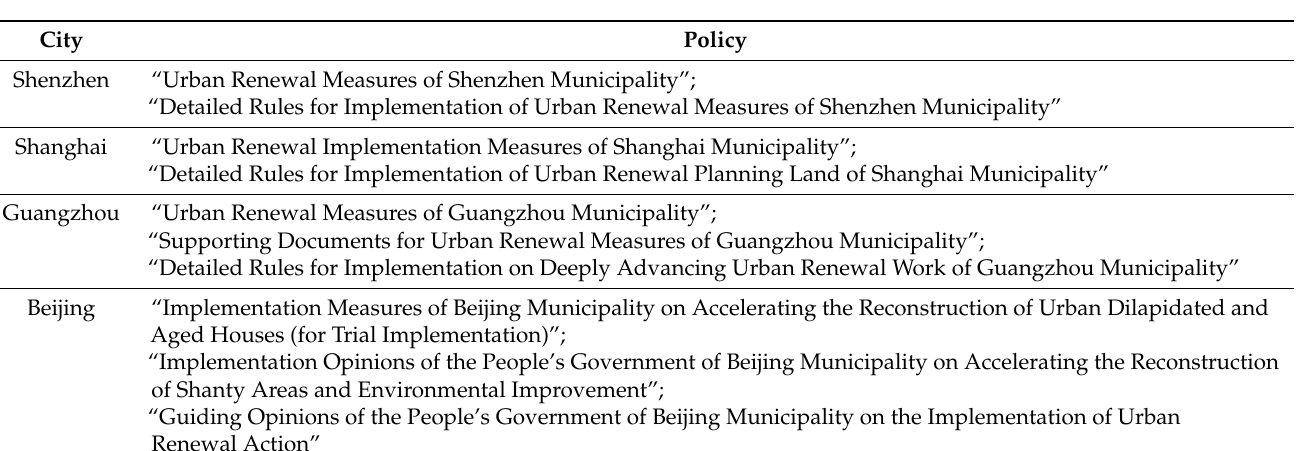
Table 8. Important urban renewal policy of the four